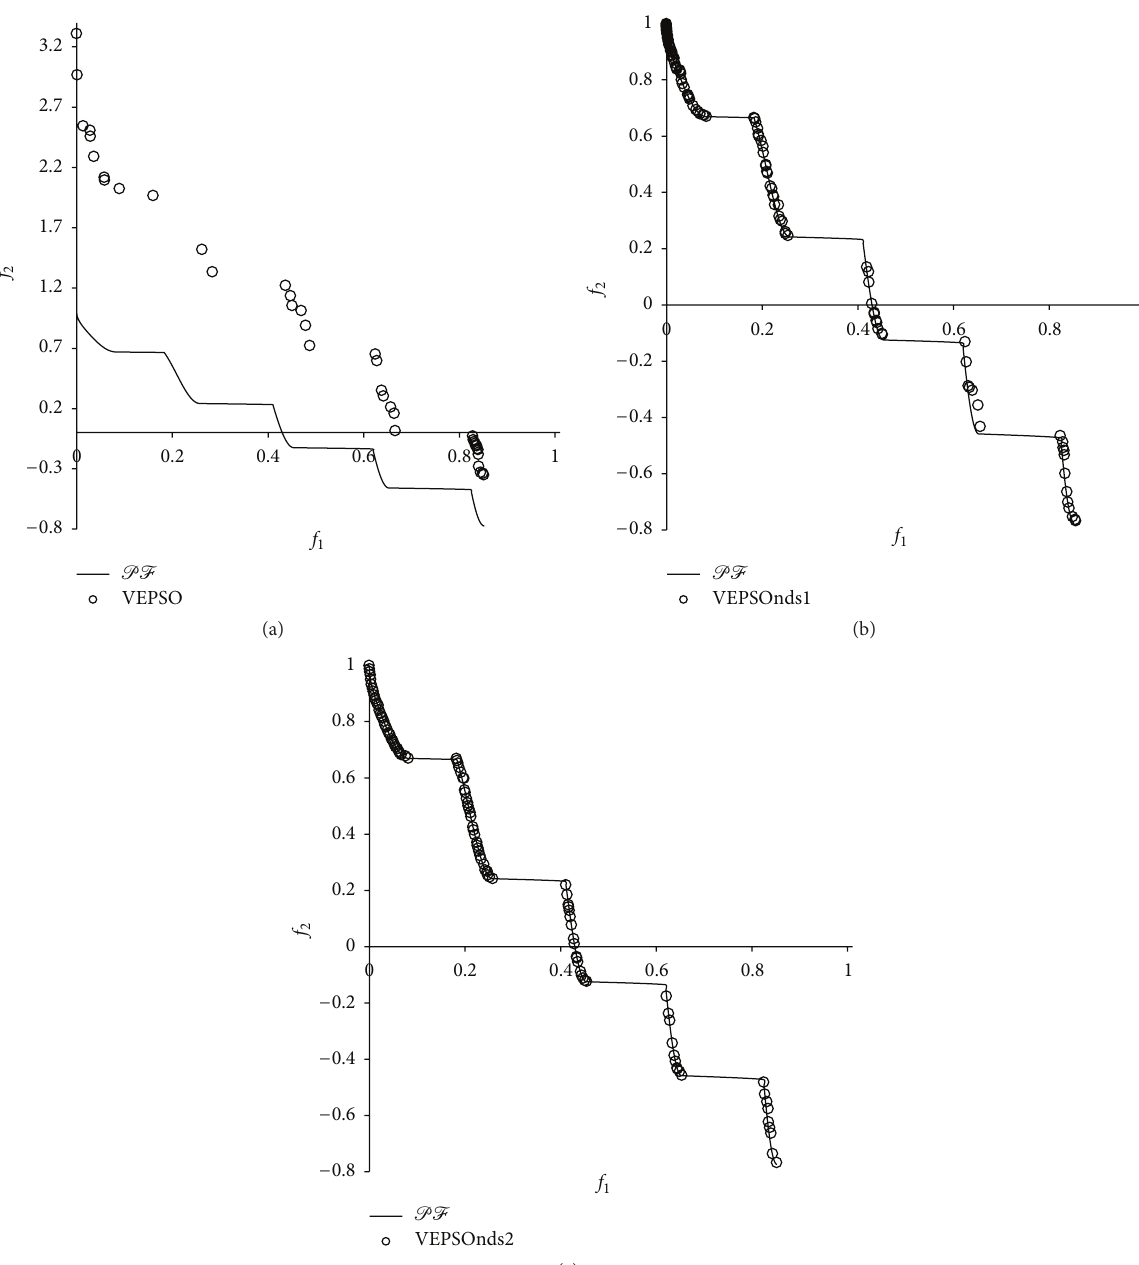
Figure 7: Plot of nondominated solutions returned by each algorithm for the ZDT3 test